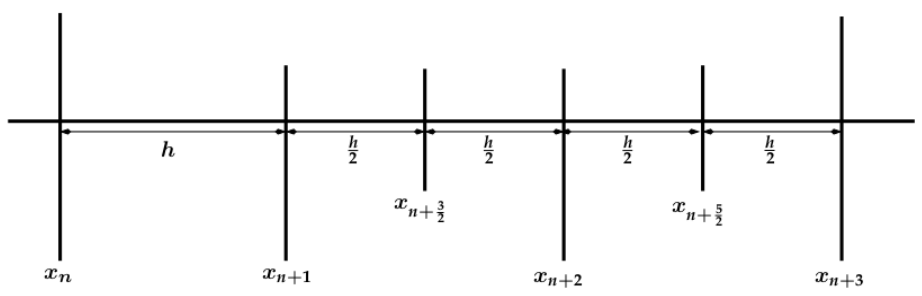
Figure 1. Unequally spaced grid points that led to ill-conditioning (Not drawn to scale).